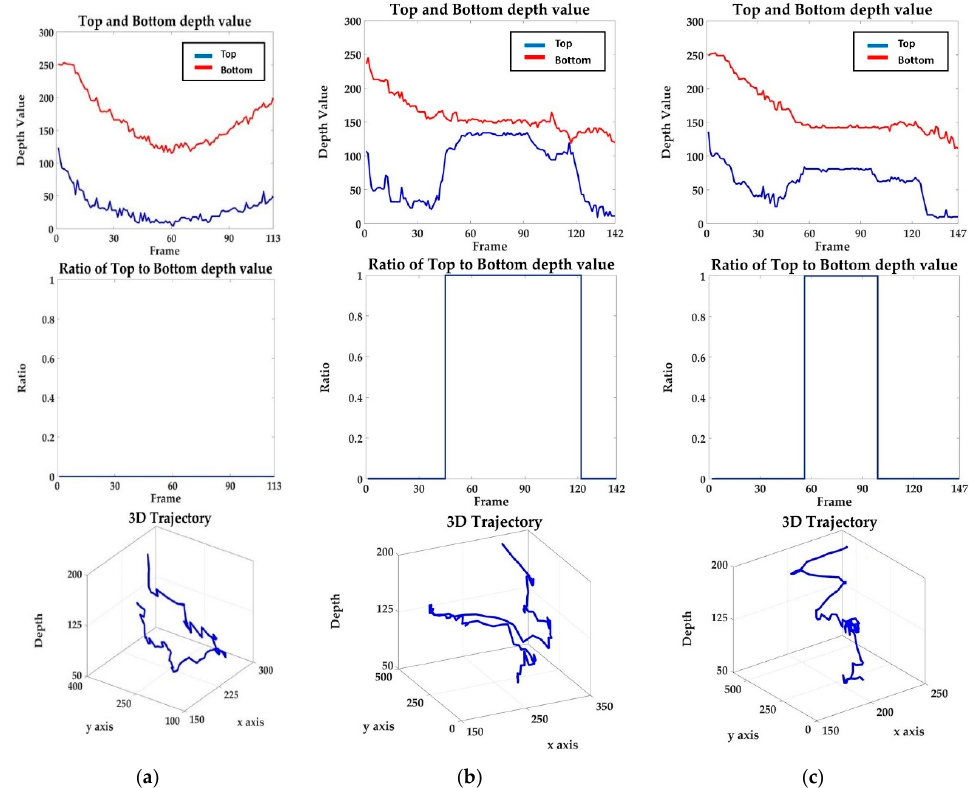
Figure 13. Top and Bottom depth values (upper line) and Ratio of Top to Bottom depth value (middle line) and 3D trajectories (bottom line): ( a ) normal walking; ( b ) sideway fall; ( c ) optical fall. Table 1. 3D mean error obtained from walking (Case 1), side fall (Case 2), front/back fall (Case